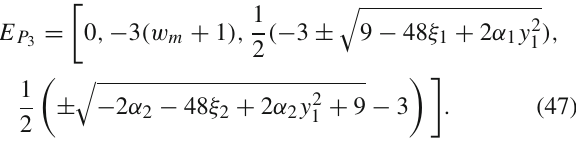
Fig. 2 The non-exclusive saddle regions for the P 2 + critical line ( ξ 1 = − 4 ,ξ = − 1 , z = 10 ,w = 0 ,α ∈ [− 10 , + 10 ] ) m 2 2 1